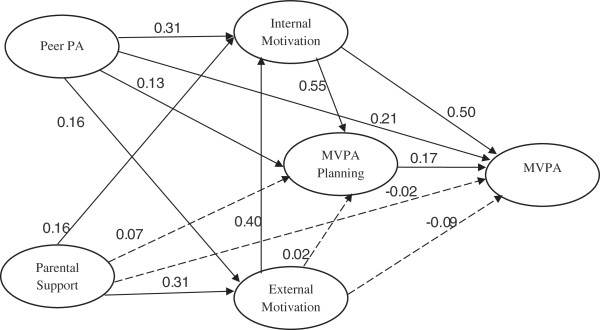
Structural equation modeling to test an integrated model of adolescent physical activity. RMSEA (90% CI) = 0.030 (0.027 – 0.034); CFI = 0.952; TLI = 0.927; χ2df = 167 = 446.542, p < 0.001; AIC = 94834.846; BIC = 95485.528; Adjusted BIC = 95110.646; SRMR = 0.035. Standardized parameter estimated; Dotted lines represent paths which are not significant; Demographic variables pointed to all latent variables but not shown. MVPA = moderate and vigorous physical activity.